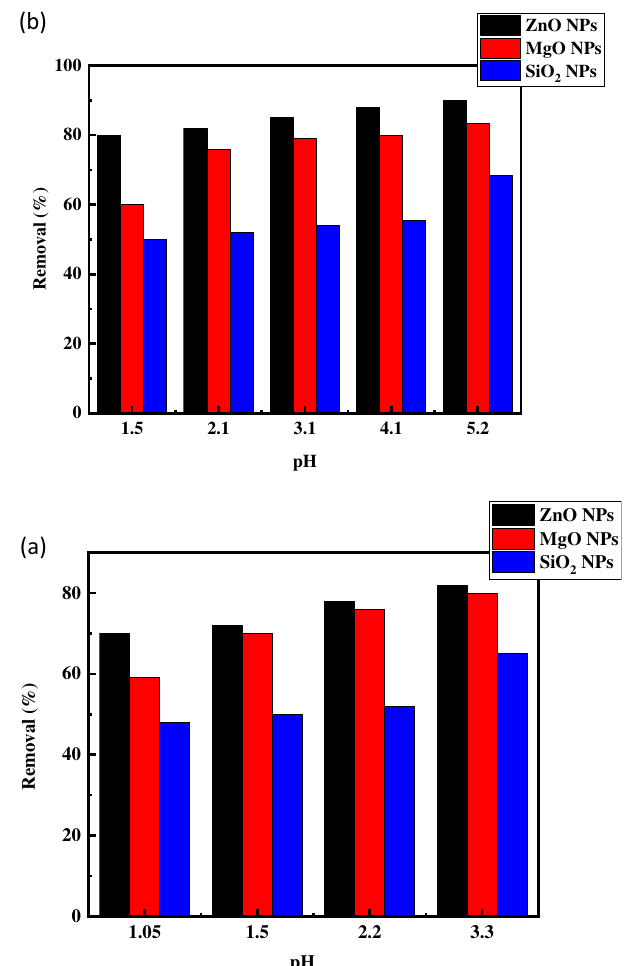
Figure 5. Effect of pH on adsorption of Cu 2+ ( a ) and Fe 3+ ( b ) ions (conditions: 10 gl −1 adsorbent, 10 ml of 50 mg L −1 of ions, duration of oscillation time of 24 h at temperature 25